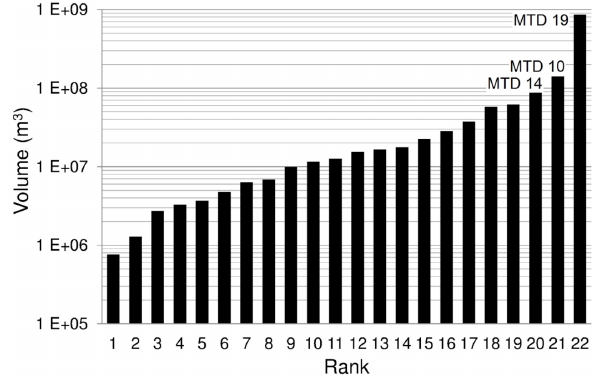
Figure 6. Volume distribution of the 22 MTDs studied in the Mornos Canyon and Delphic Plateau basins. The names given to the three largest MTDs correspond to the notation in Fig.